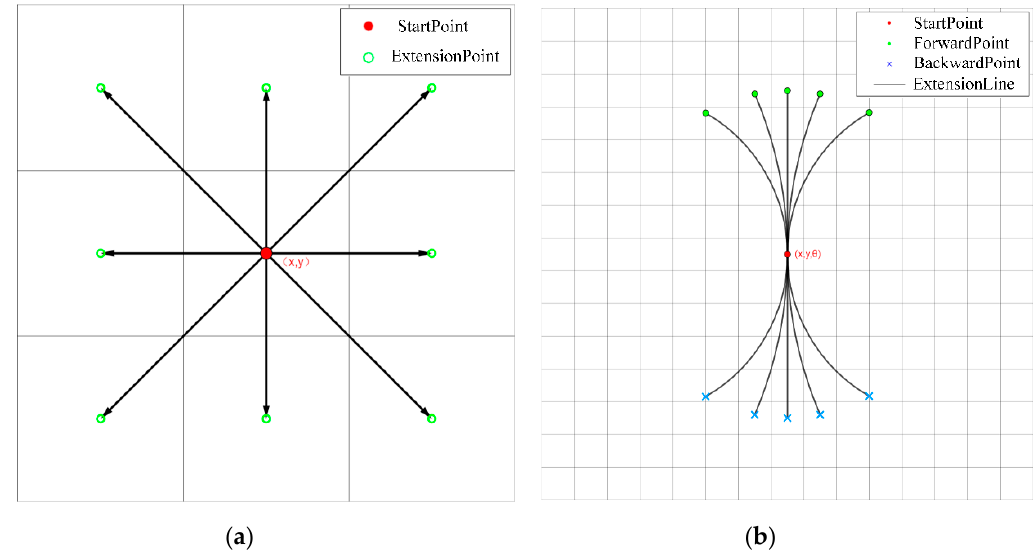
Figure 9. Schematic diagram of node extension. ( a ) is the traditional A* algorithm node extension; ( b ) is the nonholonomic constraint node extension of Hybrid A* algorithm. The central red dot is the current node and the green or blue node is the calculated next node. Appl. Sci. 2020 , 10 , x 13 of 25